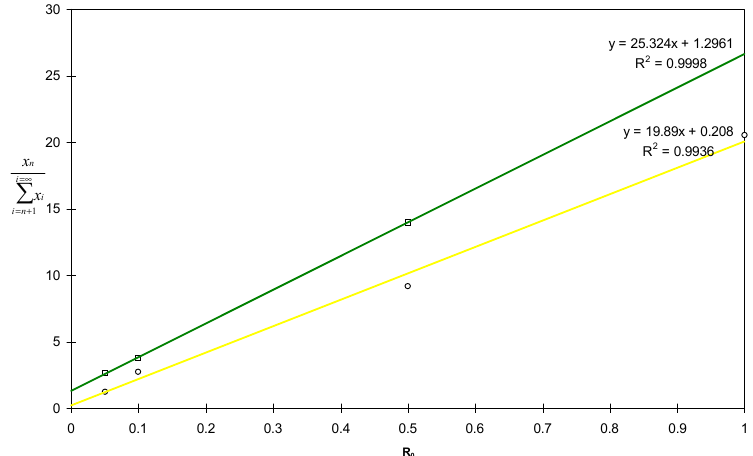
Figure 7. Molar fractions of each n telomer versus initial [CTA] 0 /[VDF] 0 molar ratio (R o ) for a given n value obtained from the telomerisation of VDF with 2-mercaptoethanol (initiated by di- tert -butyl peroxide at 140 °C, reaction times: 30 min).